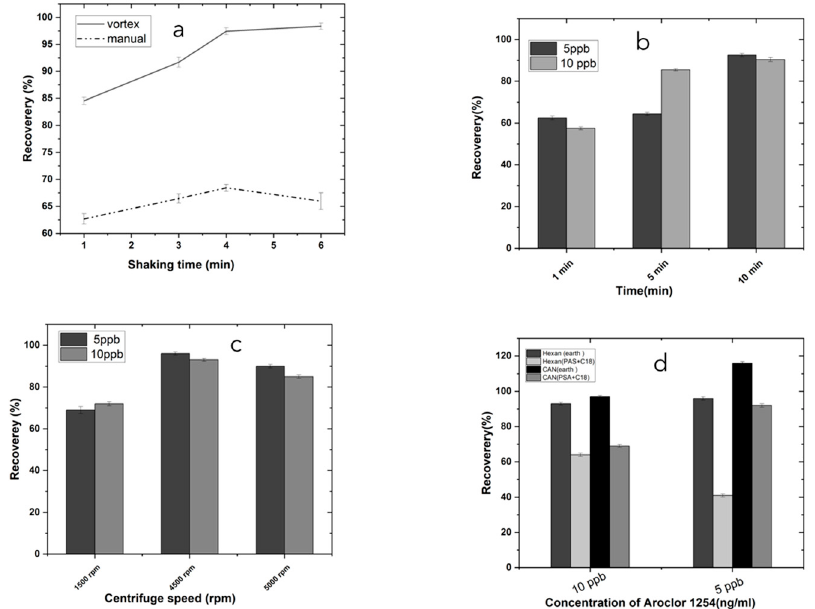
Figure 3. ( a ) Effect of shaking: 4 min, 15 mL of acetonitrile/water (75%:25%, v/v ), 5 g of soil, 4 g MgSO 4 , 1 NaCl. ( b ) Effect of centrifuge time: 4500 rpm, 15 mL of acetonitrile/water (75%:25%, v/v ), 5 g of soil, 4 g MgSO 4 , 1 NaCl. ( c ) Effect of speed: 10 min, 15 mL of acetonitrile/water (75%:25%, v/v ), 5 g of soil, 4 g MgSO 4 , 1 NaCl. ( d ) Comparison of recovery rates for different sorbents in the QuEChERS extraction method (n = 3). The conditions for the experiment were: 5 g of soil, 15 mL of acetonitrile/water (75%:25%, v/v ), 4 g of MgSO4, 1 g of NaCl, 4500 rpm.